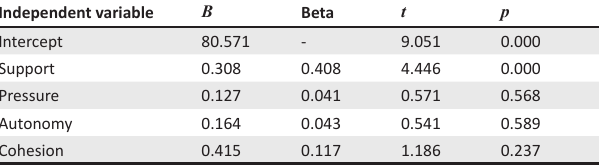
TABLE 9: Results of multiple regressions of psychological climate on team commitment subscales. Independent variable